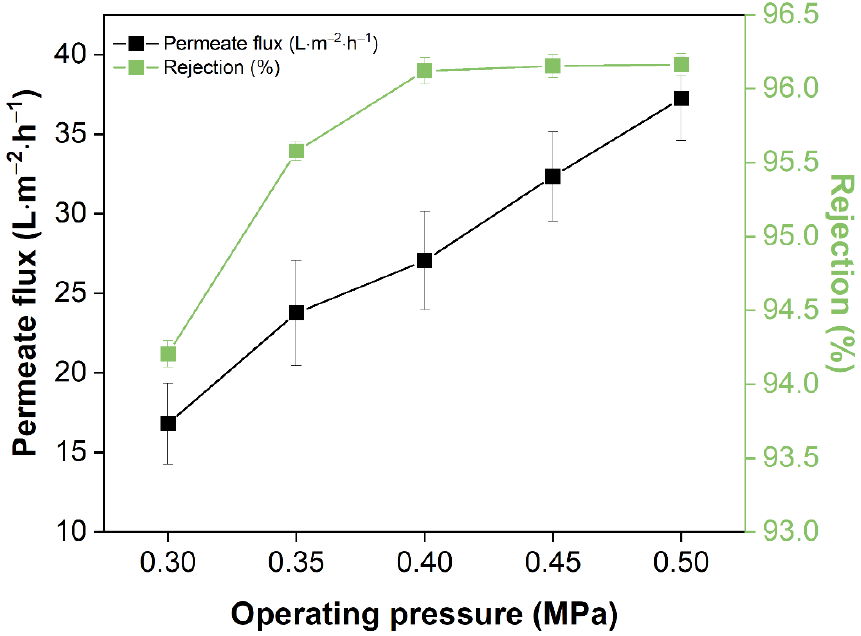
Figure 3. Permeate flux (black dot line) and rejection (green dot line) of RO membrane after 10 h running under different operating pressure from 0.30 to 0.5 MPa. Operating conditions: feed solution, Na 2 SO 4 ; feed concentration, 2500 mg·L −1 ; feed flow rate, 35 L·h −1 ; temperature, 18 °C; pH, 7.